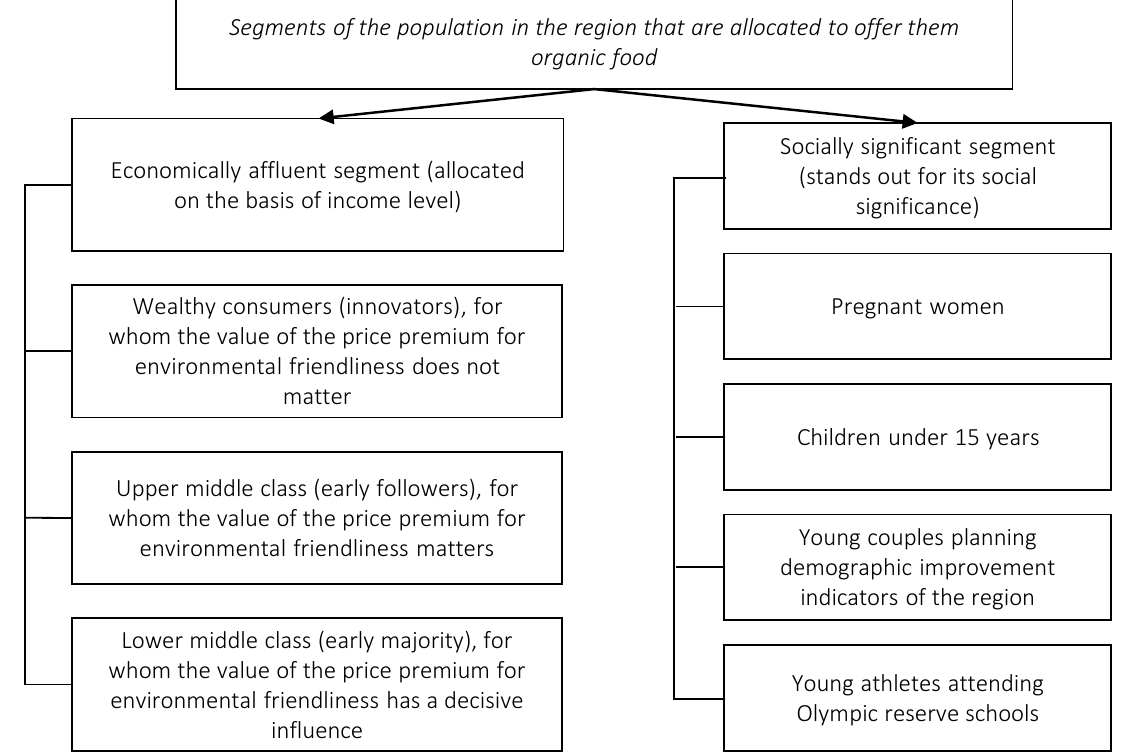
Figure 2. Segments of the population in the region that are allocated to offer them organic food (Figure 3) that reflect the regional distribution of Ukrainian households, whose members consider themselves to be middle class (in the second di- rection of development of the regional market of eco-products).